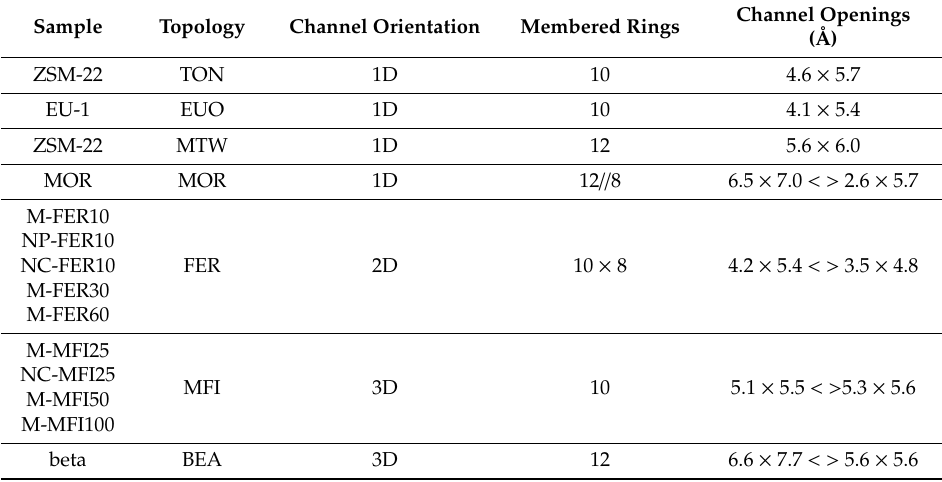
Table 1. Structure details of the investigated zeolite